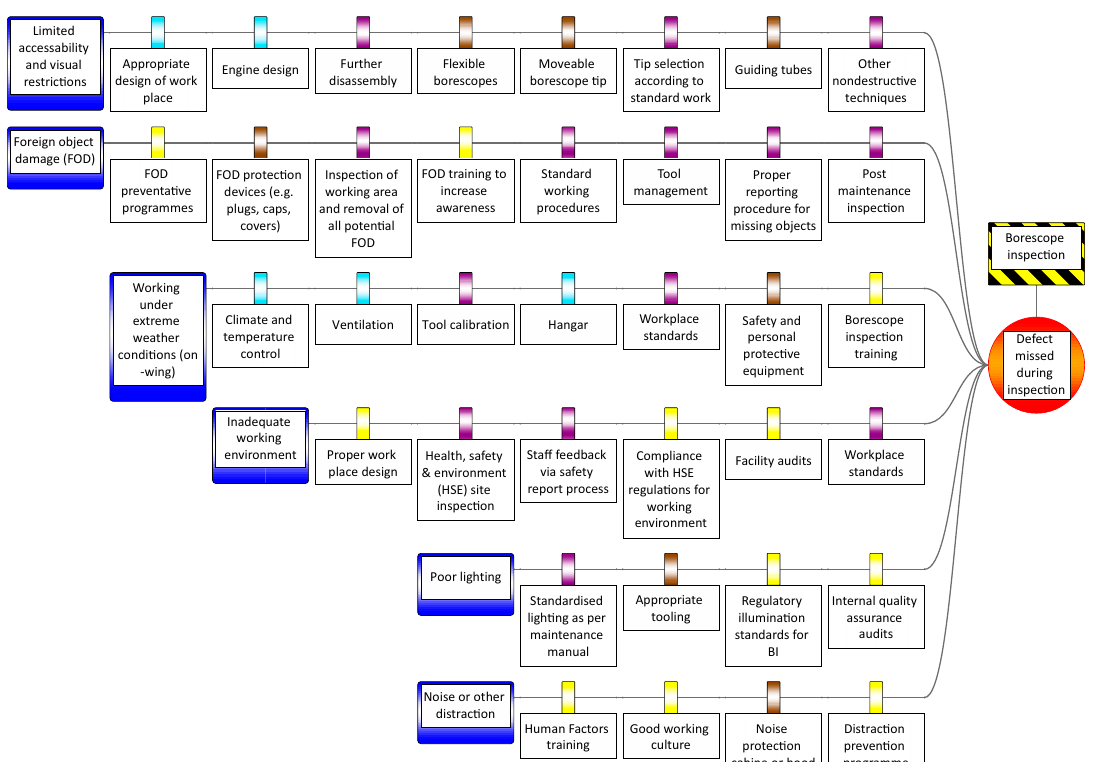
Figure A3. Mother Nature-related threat paths with barriers.